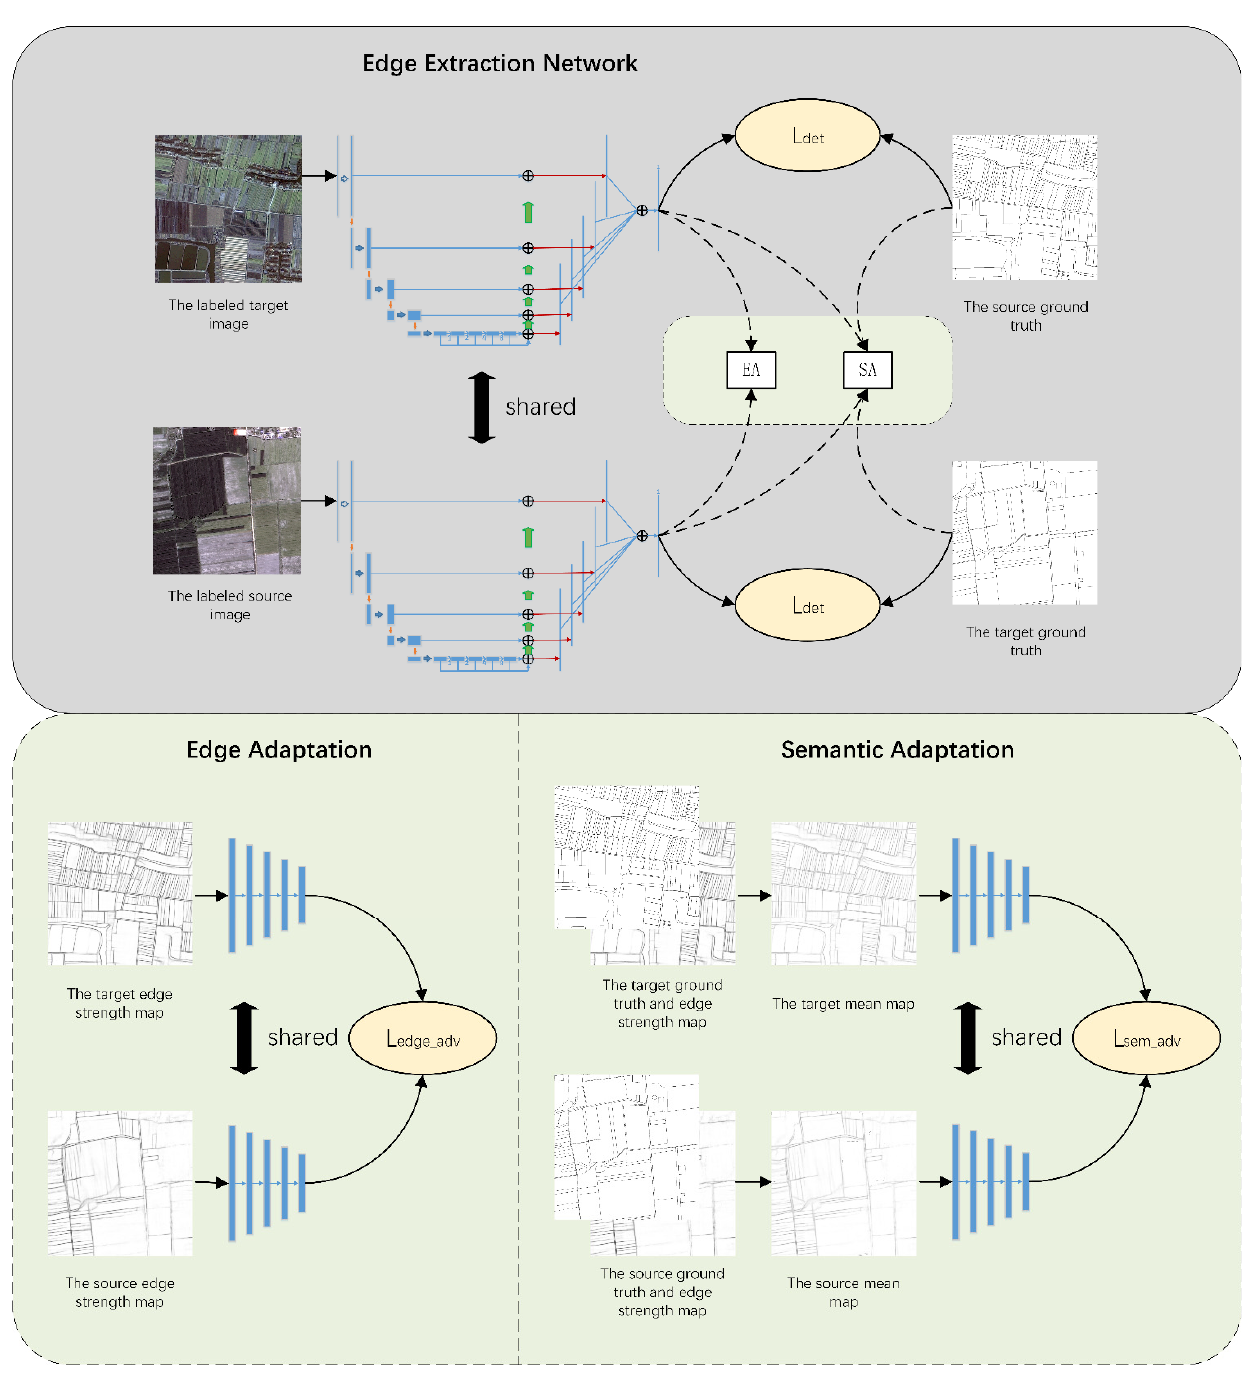
Figure 1. Algorithmic overview. The network can be divided into the following three modules: the edge detection module (ED), the edge adaptation module (EA), and the semantic adaptation module (MA). ED is used as an extractor, which is the main body of the network to detect the semantic edge of the target object. EA and MA are used as the discriminators. The EA takes the edge strength map output by the edge detection module as the input to perform domain adaptation on the edge level. MA takes the mean map of the edge strength map and the ground truth as the input to perform domain adaptation on the semantic level.